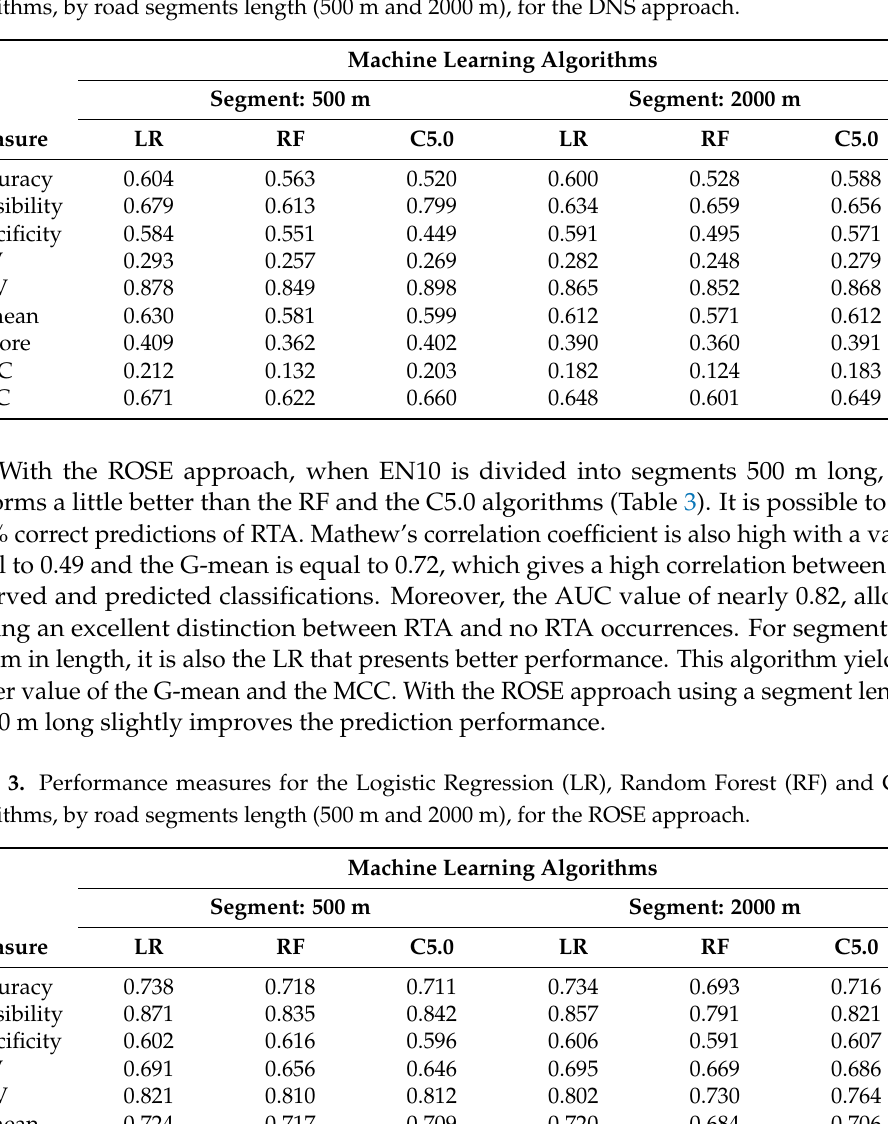
Table 2. Performance measures for the Logistic Regression (LR), Random Forest (RF) and C5.0 algorithms, by road segments length (500 m and 2000 m), for the DNS approach.